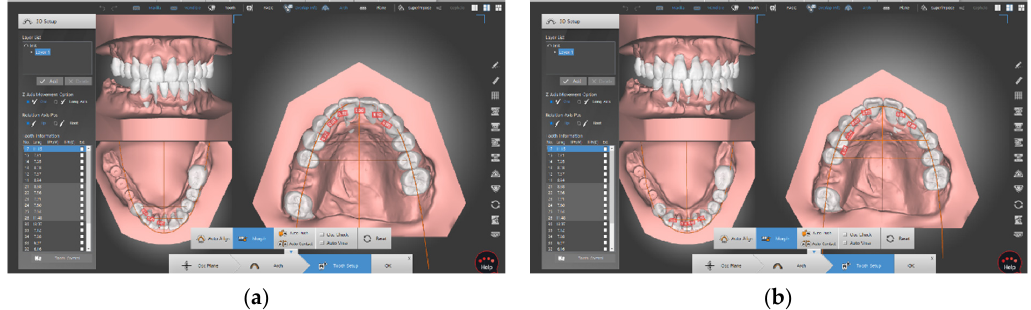
Figure 7. ( a , b ) Screen for moving each tooth to the final occlusion. It is possible to check the amount of movement of each tooth when the teeth are moved from the existing dental state to the final occlusion.